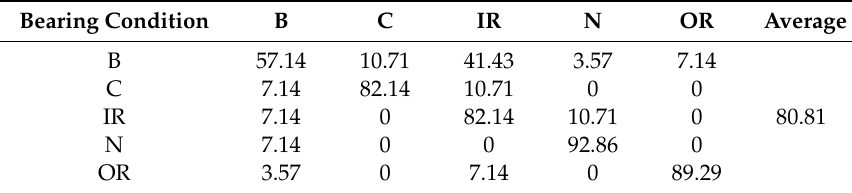
Table 9. Classification accuracy of ELM (%).